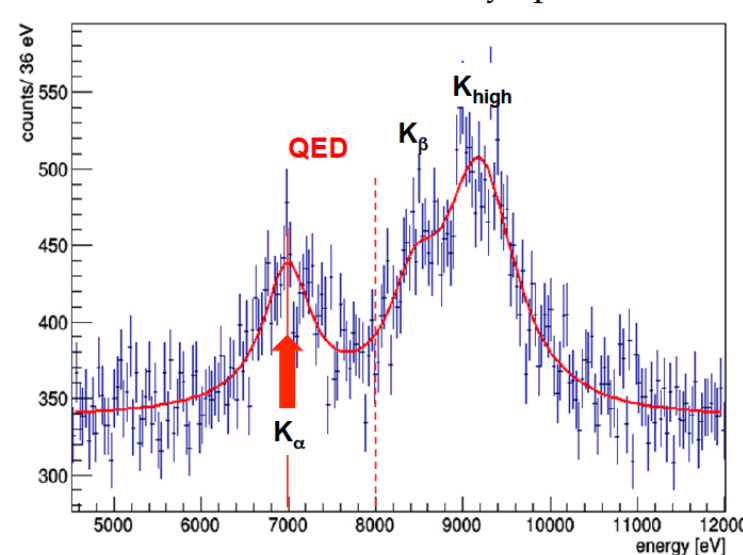
Figure 4. GEANT4 simulated kaonic deuterium X-ray spectrum (the pure electromagnetic 2p-1s tran- sition is indicated by an arrow) with a detector active area of 246 cm 2 and assuming (cid:15) 1 s = -800 eV and Γ = 800eV [19]. Withe a K alpha yield of 0.1 percent the signal-to-background ratio is 1:4. 1 s